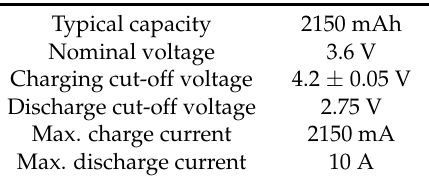
Table 1. Basic specifications of Samsung ICR18650-22P lithium-ion battery.